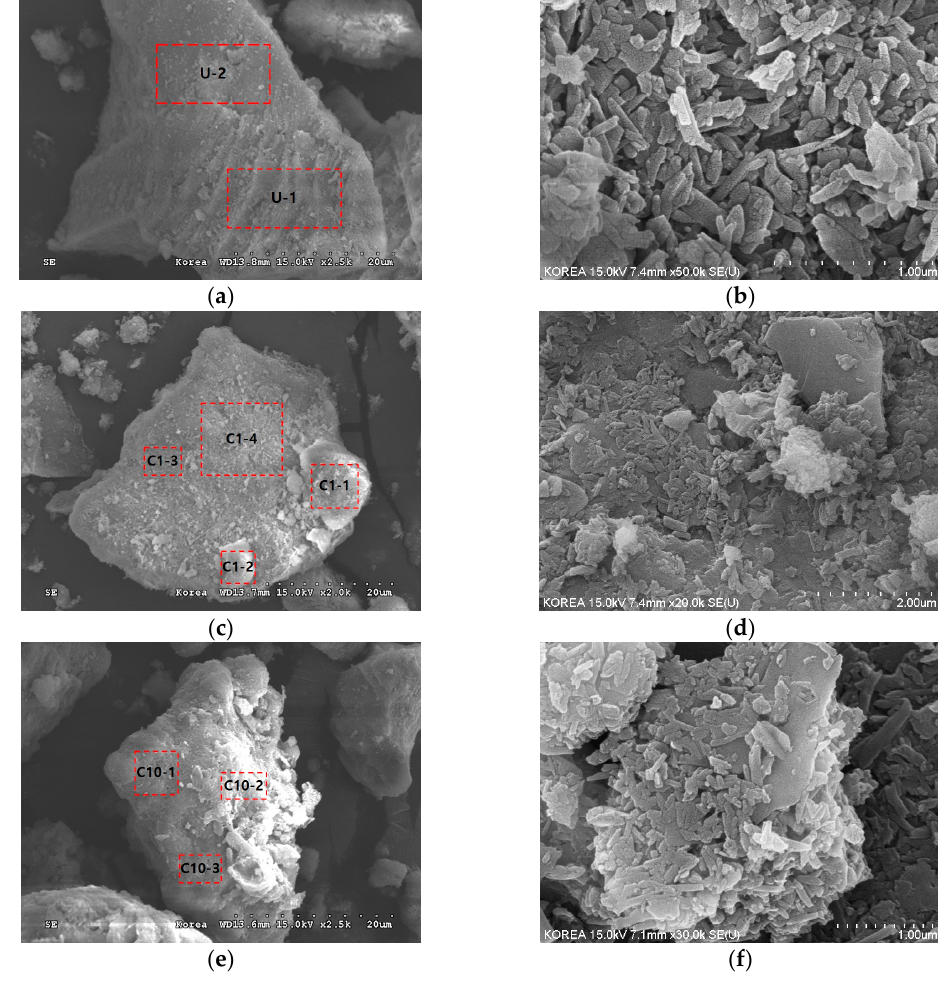
Figure 3. Field emission scanning electron microscopic (FESEM) images of untreated and treated soils with different concentrations (C O ) of organosilane solution: ( a , b ) untreated; ( c , d ) C O = 1%; and ( e , f ) C O = 10%. Note that the energy dispersive X-ray (EDX) analysis was conducted on the marked areas in the figure, and the EDX results are tabulated in Table 3. Table 3. Energy dispersive X-ray analysis results.